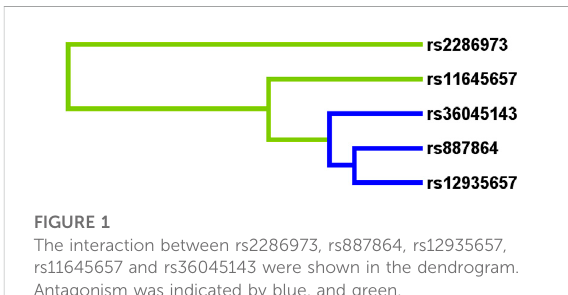
rs11645657 and rs36045143 were shown in the dendrogram. Antagonism was indicated by blue, and green.